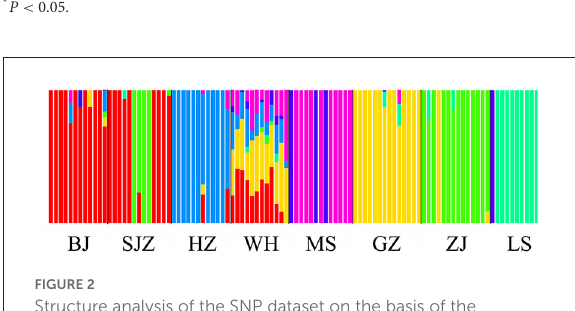
FIGURE2 Structure analysis of the SNP dataset on the basis of the Maximum-Likelihood clustering method.